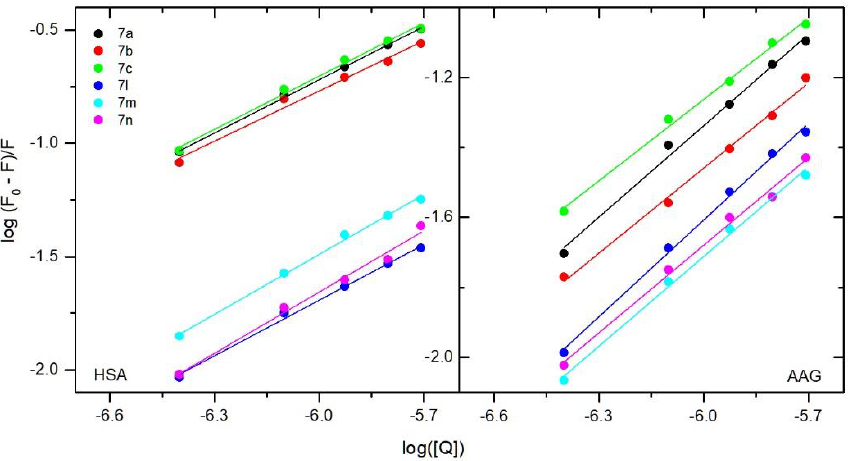
Figure 8. Double-logarithm-regression plots for quenching of human serum albumin (HSA) ( left ) and alpha-1-acid glycoprotein (AAG) ( right ) by compounds 7a – 7c and 7l – 7m .